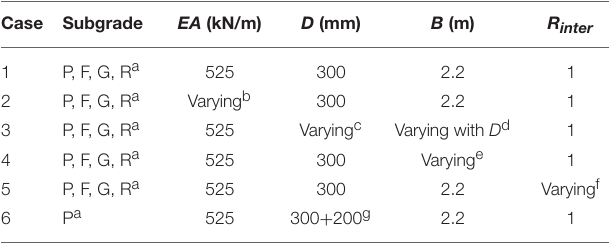
TABLE 3 | Parameter setting for the monotonic loading cases. TABLE 4 | Results of Case 1 with respect to the factor of subgrade